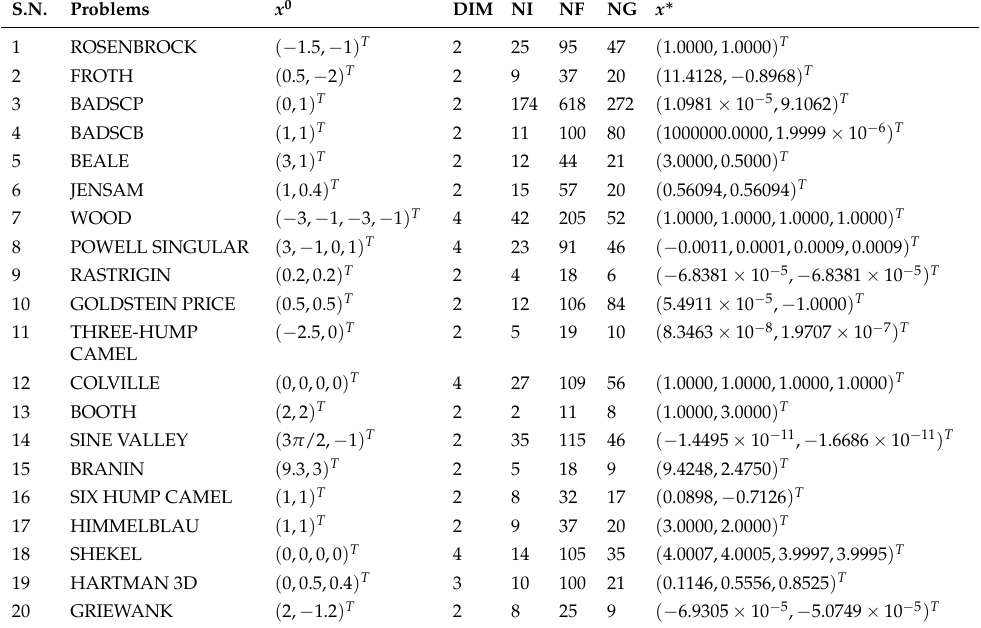
Table 7. Numerical results for Modified q -BFGS algorithm.